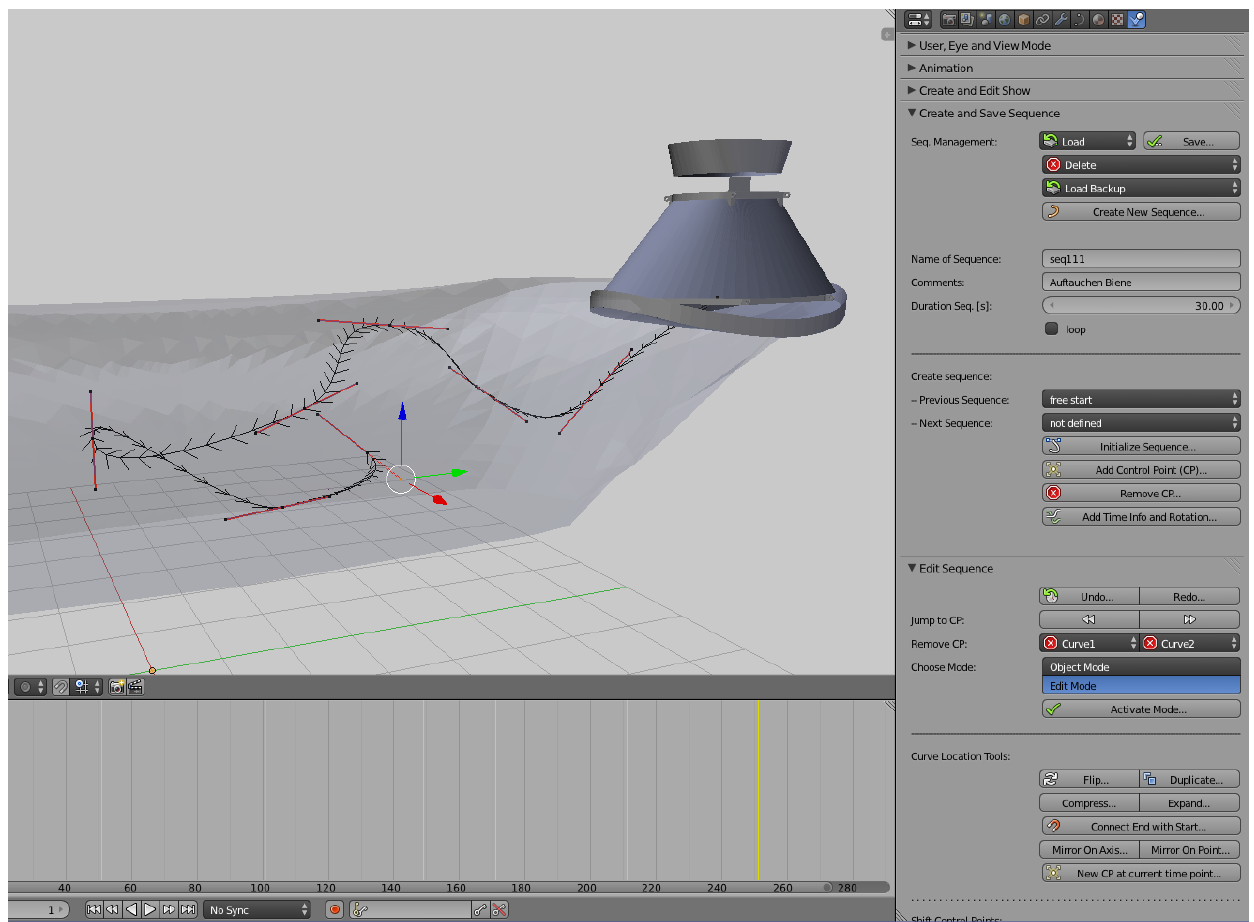
Figure 3. Extract of the path planning tool provided as an add-on for Blender.